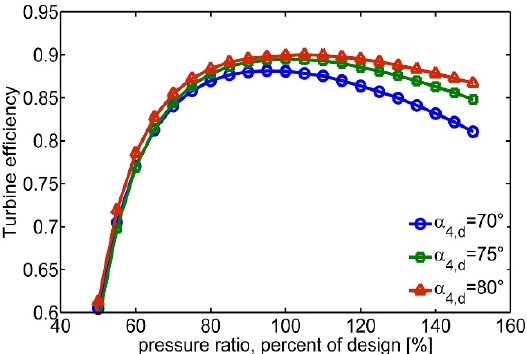
Figure 10. Turbine performance under pressure ratio change.